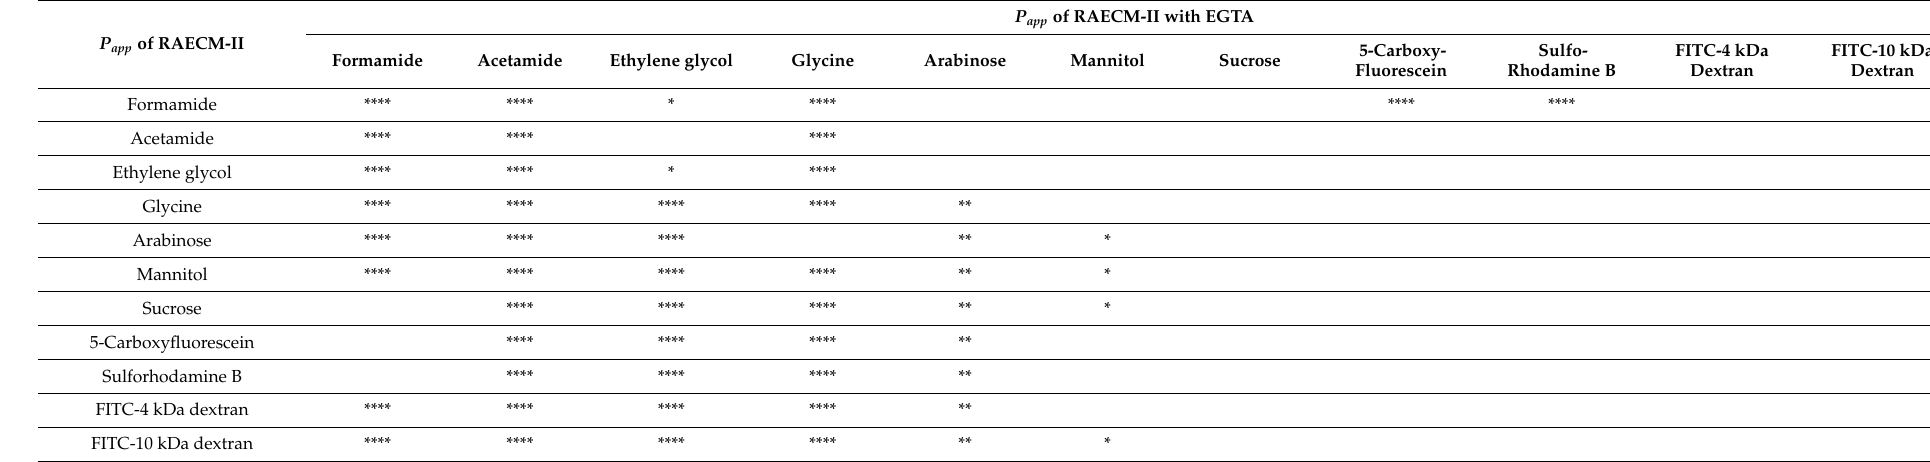
Table A2. Cont. ( e ) Comparison table for P app of RAECM-II vs RAECM-II with EGTA.